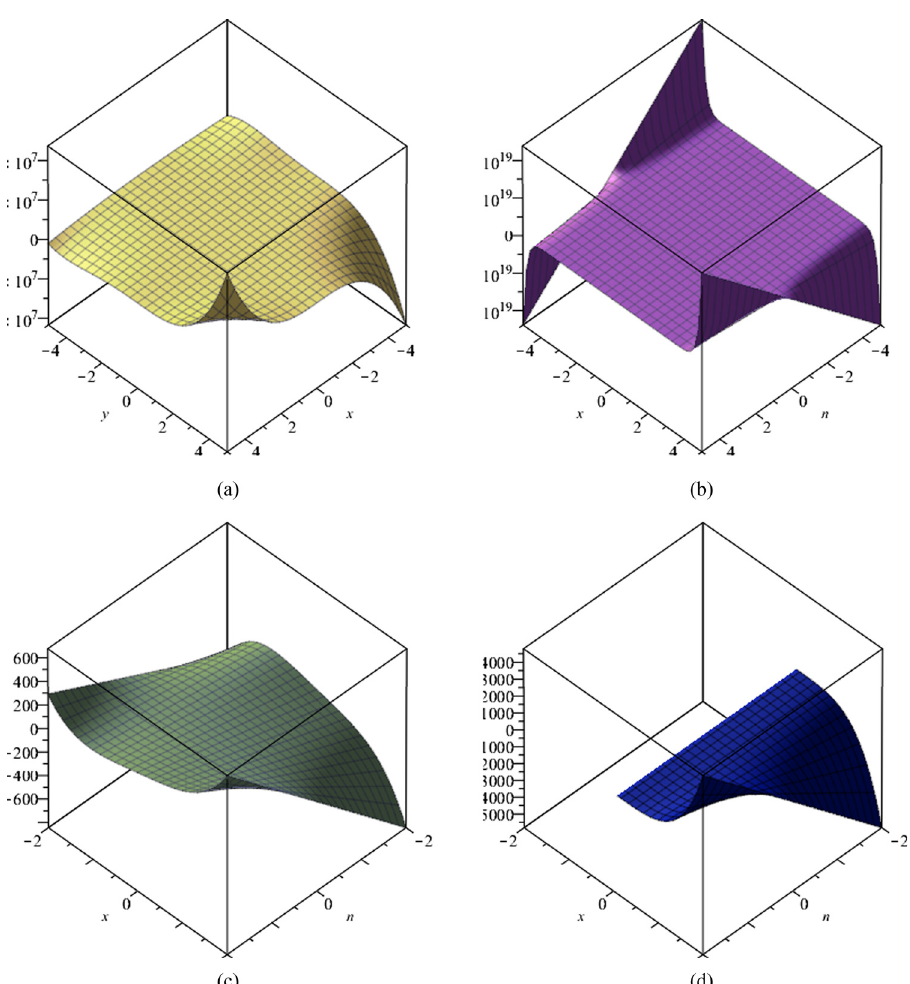
Figure 2: ( a ) M - polynomial, ( b ) F - polynomial, ( c ) S - polynomial, and ( d ) SO - polynomial of TM -